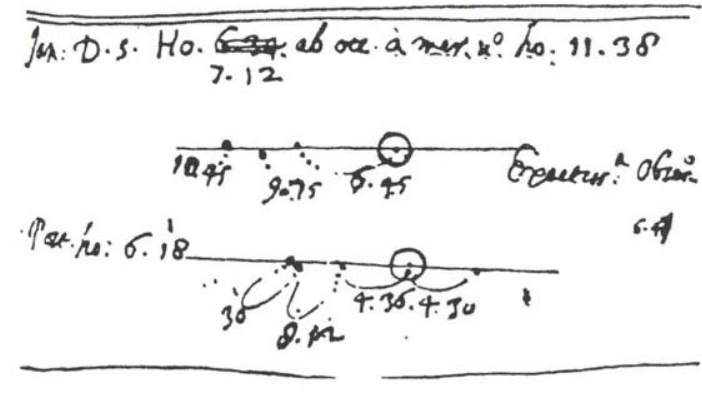
Fig. 4. Galileo's drawings of January 5 - 6, 1613. In the second, the spot to the lower right is just where Neptune was at that time. Magnification of the spot shows that it was an intentional mark, made with